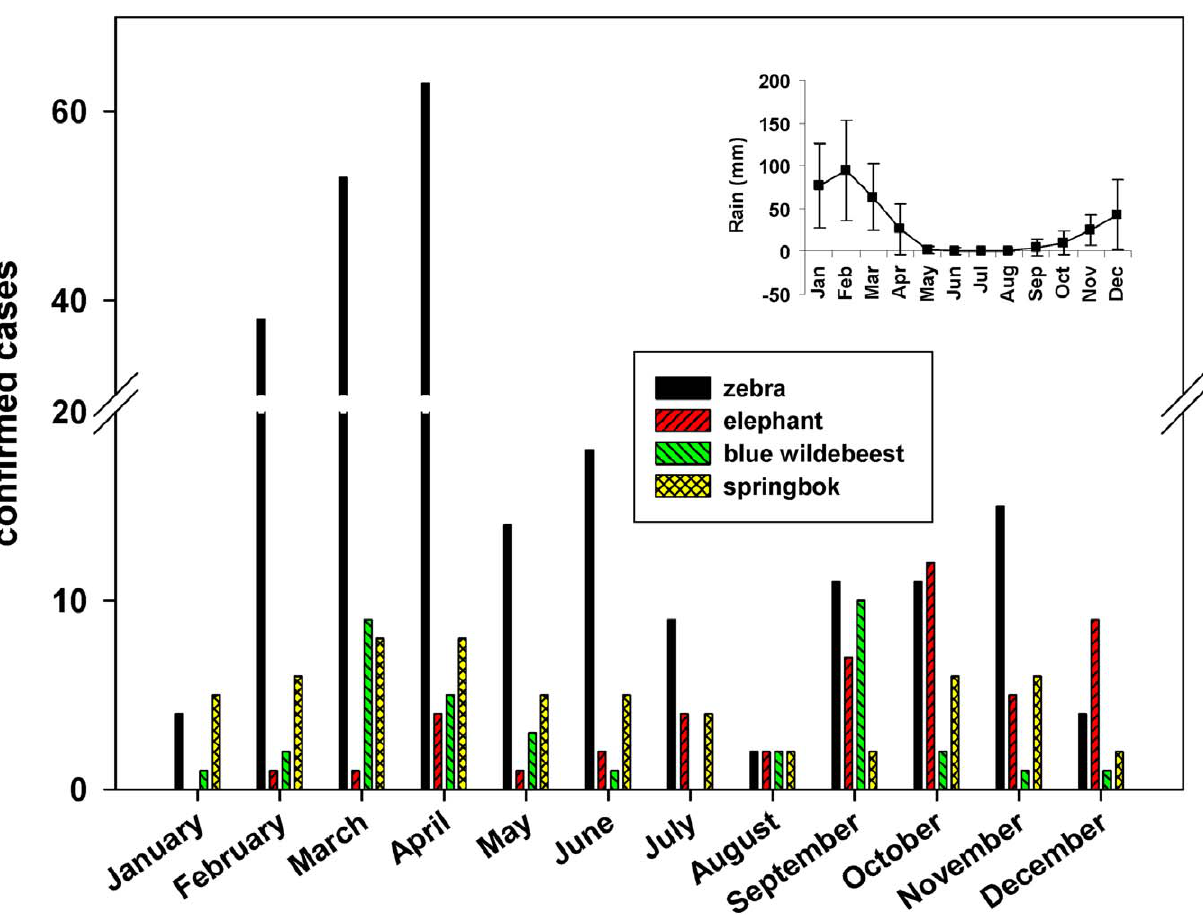
Figure 6. Confirmed cases of anthrax in the four most commonly affected species in the ENP. The period between 1988–2010 is shown. Isolates prior to 1988 have been excluded from this figure, having been collected during only short field studies in the Park. The insert indicates the mean monthly rain fall (in l/m 2 ) in the Okaukuejo region, in 1983–2010.